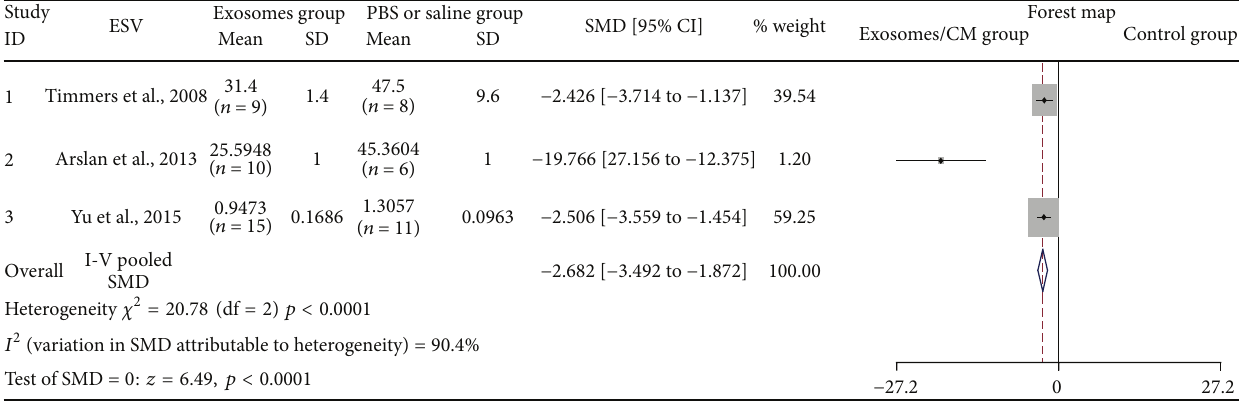
Figure 8: The effectiveness of exosomes on